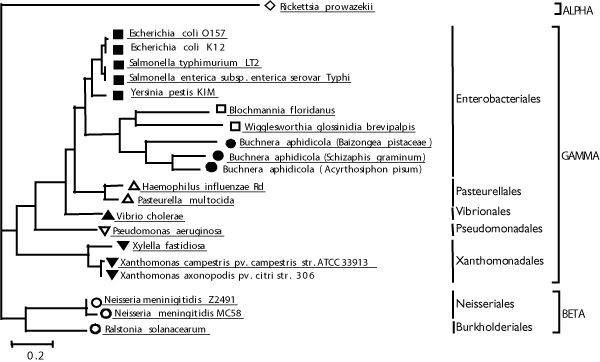
Supermatrix analyses. Number of concatenates out of 100 that recovered the RT (columns, left y-axis) for the 'essential' (blue) and the 'universal' (green) cores. The lines represent the average Robinson-Foulds distance (right y-axis) with standard errors from the 100 concatenates that compose each category for the 'essential' (blue) and 'universal' (green) cores.